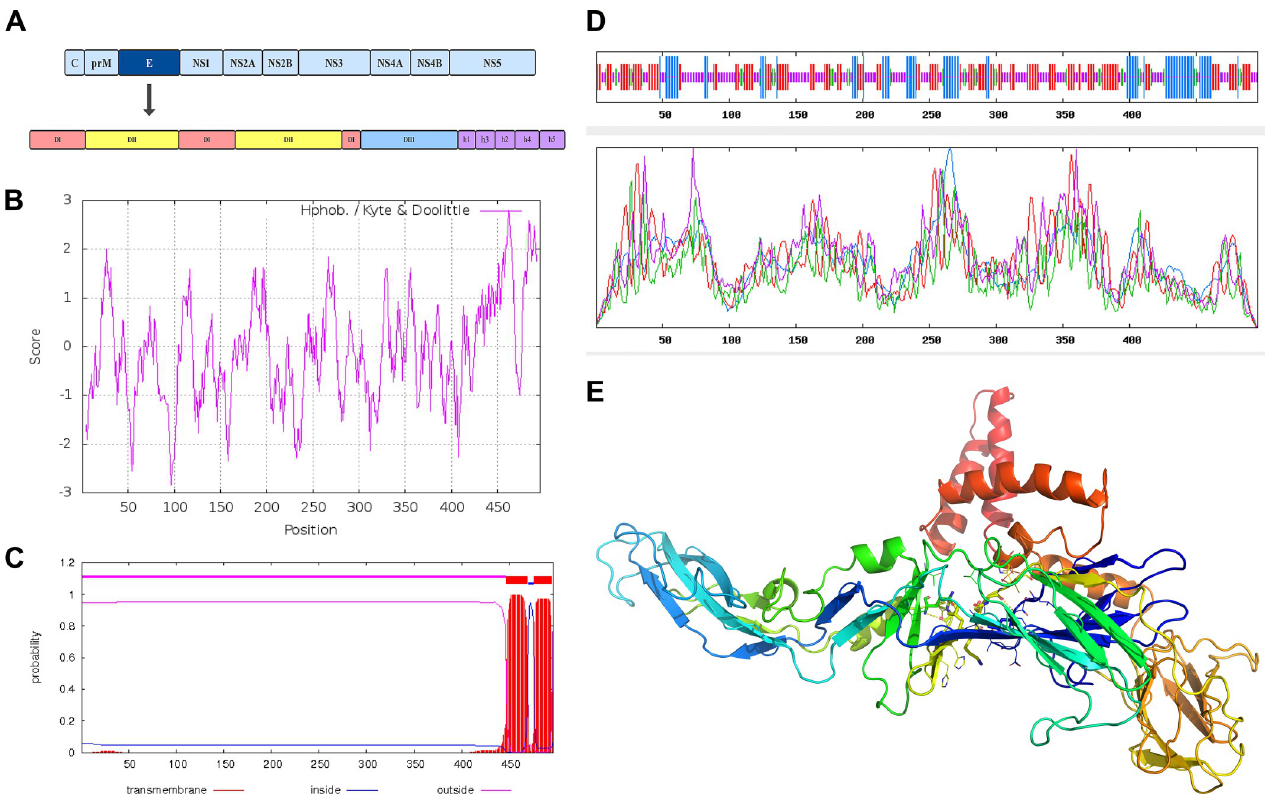
Fig 4. Physicochemical properties and structural features of E protein of Senzhang strain. A: Schematic diagram of E protein structural domains. B: Hydrophobicity evaluation of E protein. C: Predicted transmembrane region of E protein. D: Predicted secondary structure of E protein. E: A tertiary structural model of E